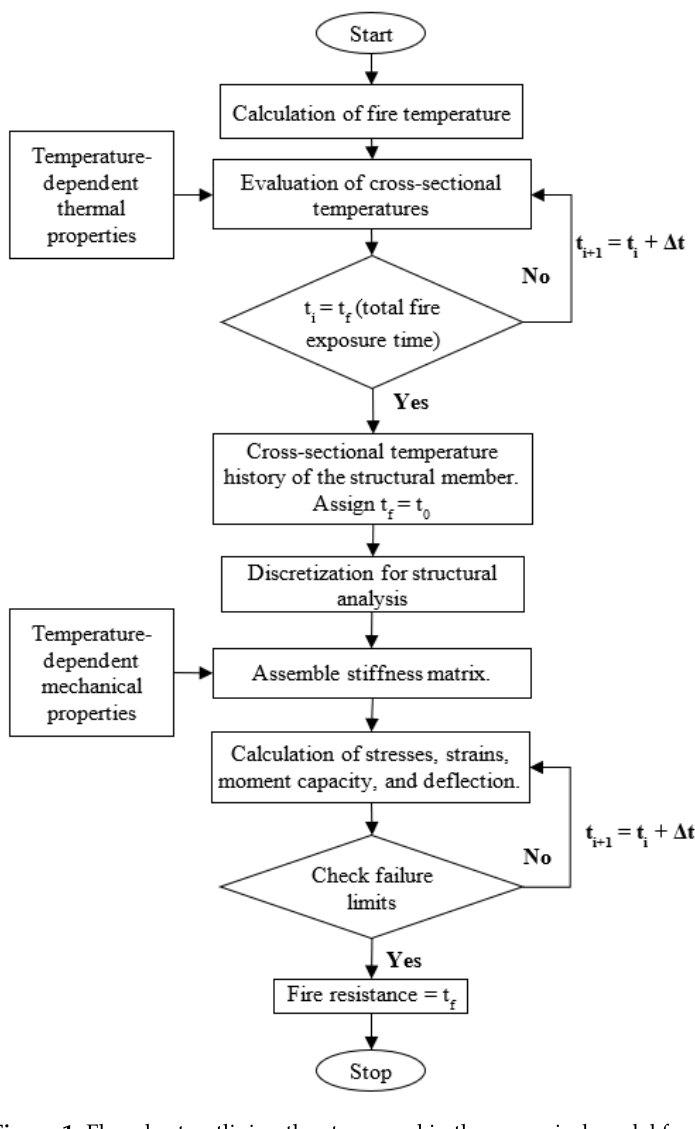
Figure 1. Flowchart outlining the steps used in the numerical model for evaluating the fire resistance of FRP-strengthened RC members.